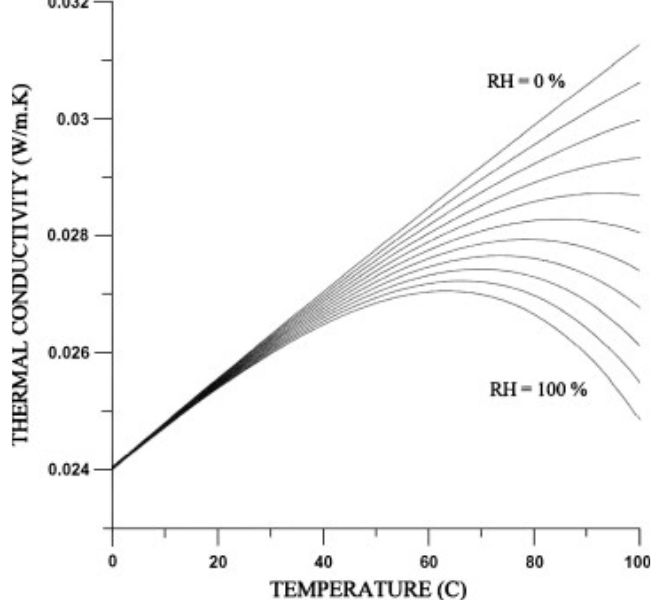
Figure 10. The thermal conductivity of moist air as a function of temperature with the relative humidity as a parameter ranging between dry air (top curve RH = 0%) and saturation conditions (lower curve RH = 100%) in 10% steps. Figure from [46].